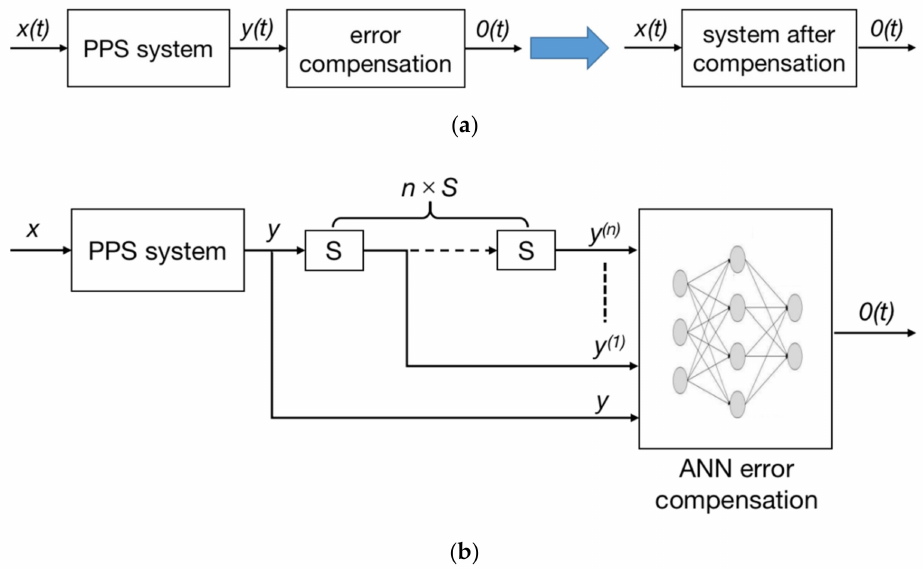
Figure 11. Compensation principle and algorithm block diagram: ( a ) basic compensation principle; ( b ) algorithm structure